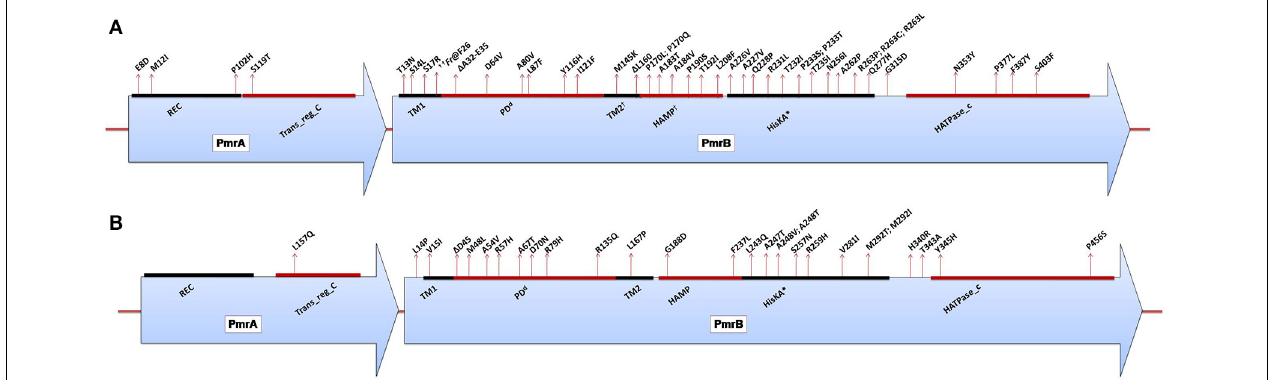
FIGURE 4 | (A) Domains of the PmrA/PmrB two-component system and positions of all mutations conferring polymyxin resistance to Acinetobacter baumannii . PmrA domains , cheY-homologous receiver domain [REC]; aa 2–112. Transcriptional regulatory protein, C-terminal domain [Trans_reg_C]; aa 150–221. PmrB domains , First transmembrane domain [TM1]; aa 10–29. d Periplasmic domain [PD]; aa 29–142. † Second transmembrane domain [TM2]; aa 142–164. † Histidine kinases, adenylyl cyclases, methyl-binding proteins, and phosphatases [HAMP domain]; aa 145–214. Histidine kinase A (phosphoacceptor) domain [HisKA]; aa 218–280. Histidine kinase-like ATPases [HATPase_c]; aa 326–437. ∗ HisKA, with the active site at H228 in PmrB of